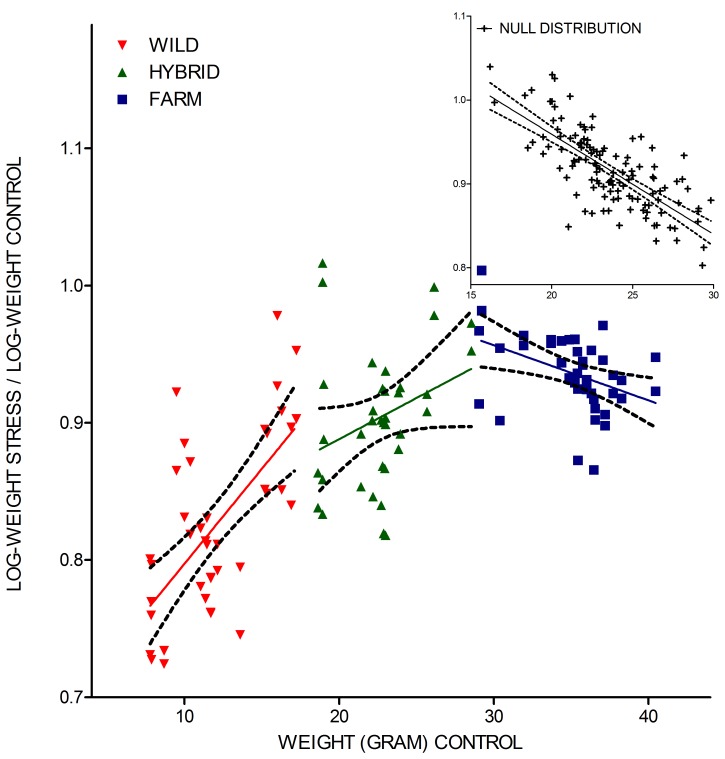
Pearson correlations between performance ratio and mean family weight in the control treatment.Performance ratio (mean log-weight in the stress treatment x relative to mean log-weight in the control treatment y) plotted against the mean family weight in the control treatment y for wild, hybrid and farmed families, including regression lines. A significant positive correlation, a non-significant correlation and a significant negative correlation were detected for the wild, hybrid and farmed families, respectively. The regression line is shown with a 95% confidence interval. The null hypothesis, illustrated by 120 randomly generated values of the true mean of both treatments (SD = 10% of the mean), illustrates a negative correlation under the null distribution.